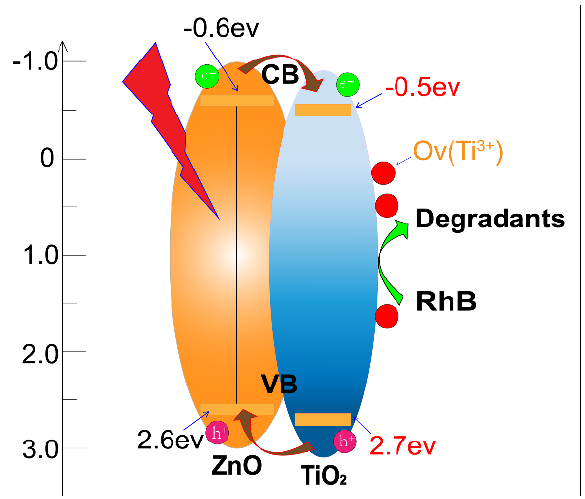
Figure 11. ZnO/TiO 2 film degradation RhB solution mechanism.